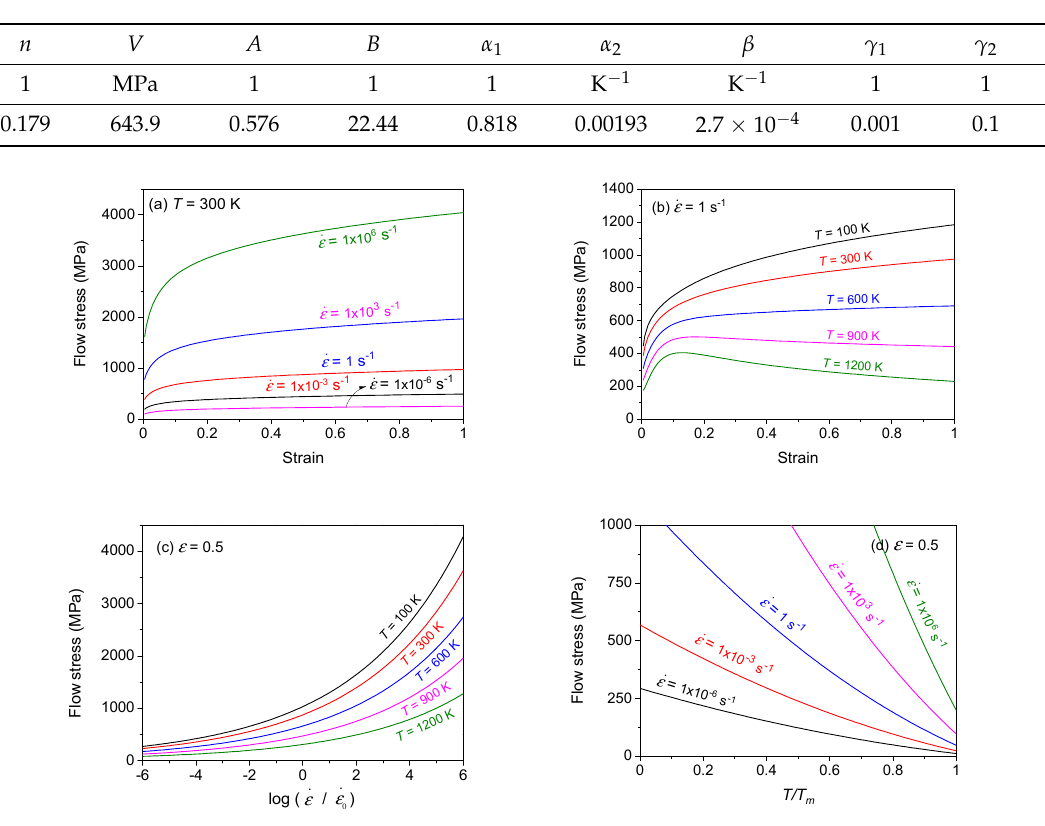
. . ε 0 = 1 s − 1 , ε ∗ = 1 s − 1 , T 0 = 298 K, and